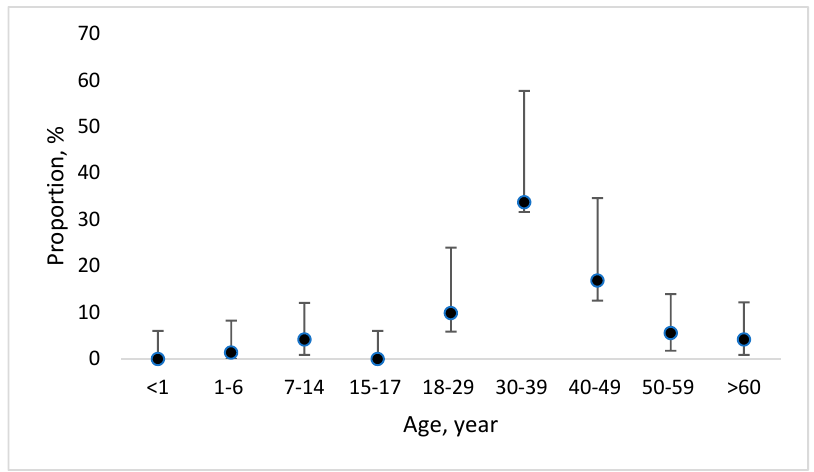
Figure 1. Proportion with 95% confidence interval of officially reported cryptosporidiosis cases per age group over the time period from 2000 to 2020 in Latvia.